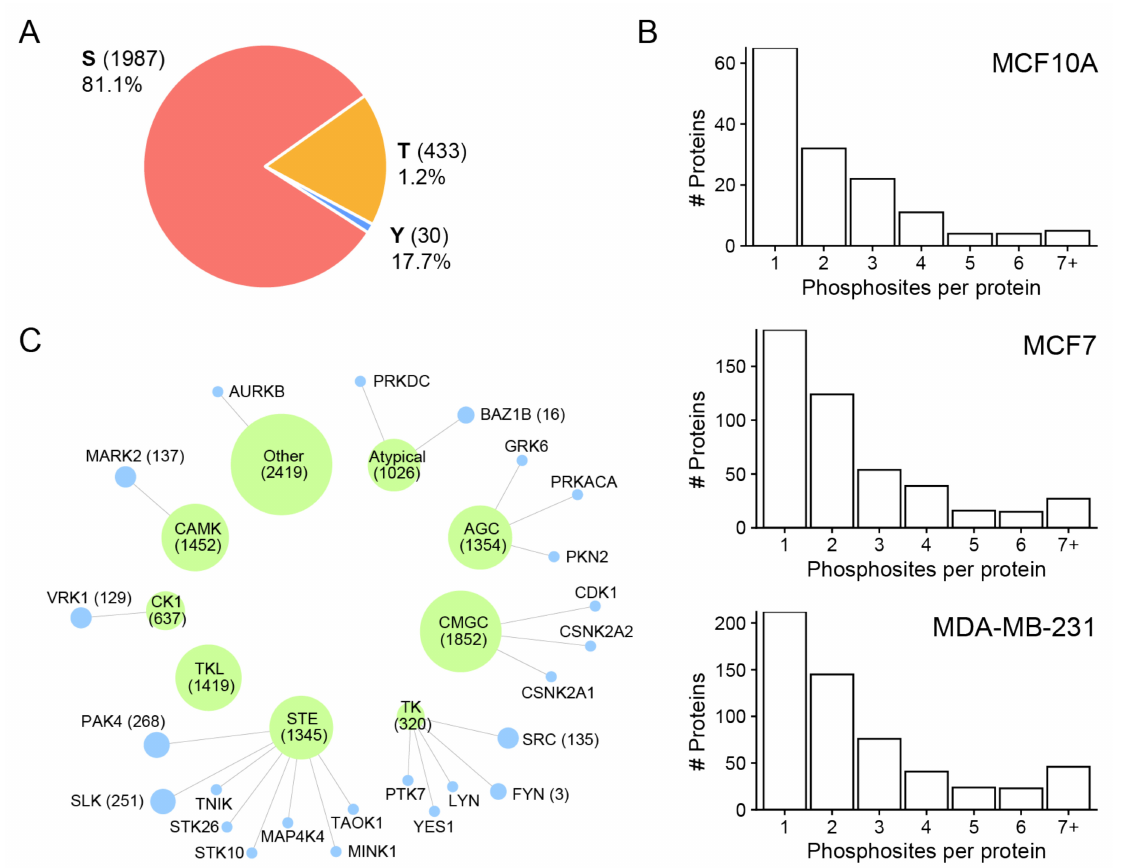
Figure 3. Overview of the identified phosphosites and frequency distribution of phosphorylated amino acid and phosphorylation motifs. ( A ) Frequency distribution of phosphorylated amino acid: pS, pY, and pY. ( B ) Numbers of sites observed per protein in all three sEV fractions. ( C ) Pie chart representation of predicted kinases groups (green) and their link to identified kinases (blue) in MDA-MB-231 sEVs [6]. Node size represents the scaled number of predicted phosphorylation